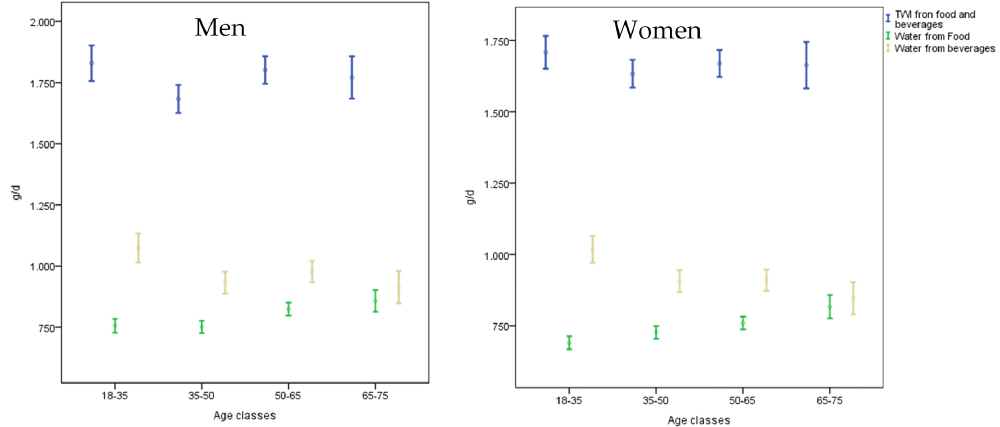
Figure 3. Mean and Confidence Interval (CI) of the Total Water Intake (TWI) from food